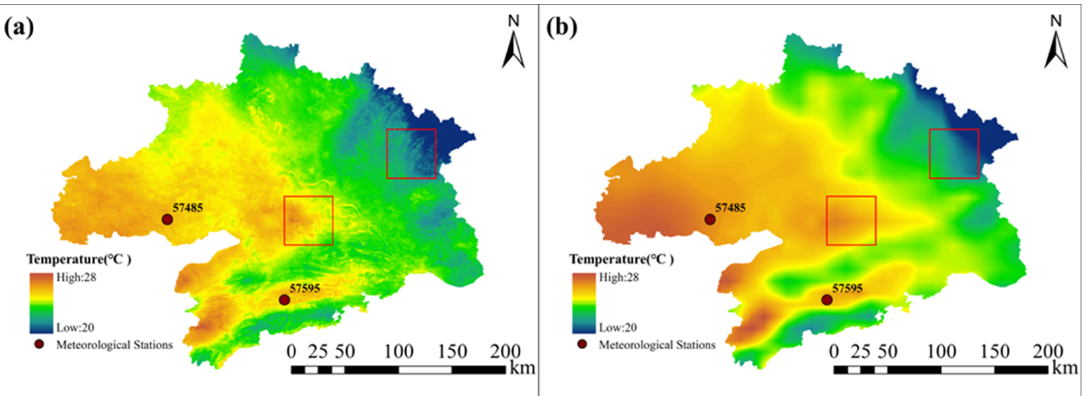
Figure 11. The spatial distribution of ERA5-Land temperature and fusion temperature on October 1st in WMA. ( a ) and ( b ) represent the fusion temperature and ERA5-Land temperature, respectively. The Red Boxes showed the detail difference between these two air temperature data in the same subarea.